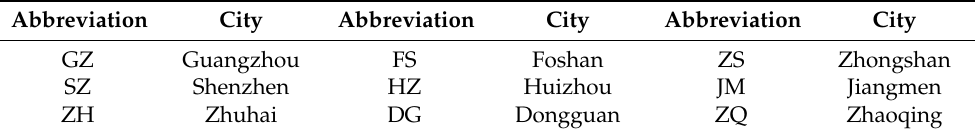
Table 2. Selected